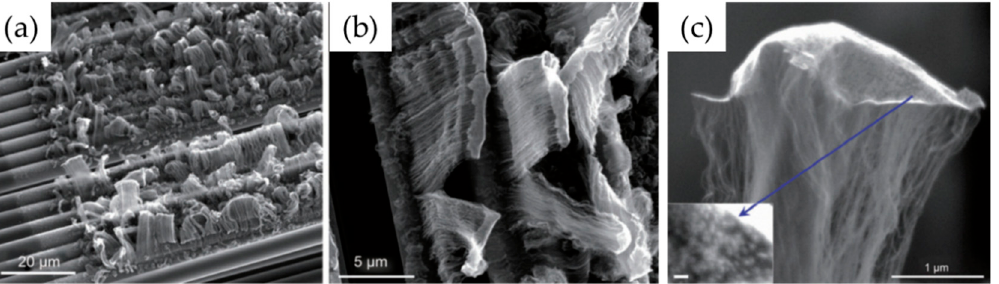
Figure 29. ( a ) SEM micrograph of ‘ Odako ’ grown SWNTs on CFs. ( b , c ) are zoom of ( a ) to confirm the presence of detached alumina flakes with insert in ( c ) showing Fe catalyst that supports tip-growth of VACNT. Scale bar in ( c ) of 50 nm. Reported after [131].